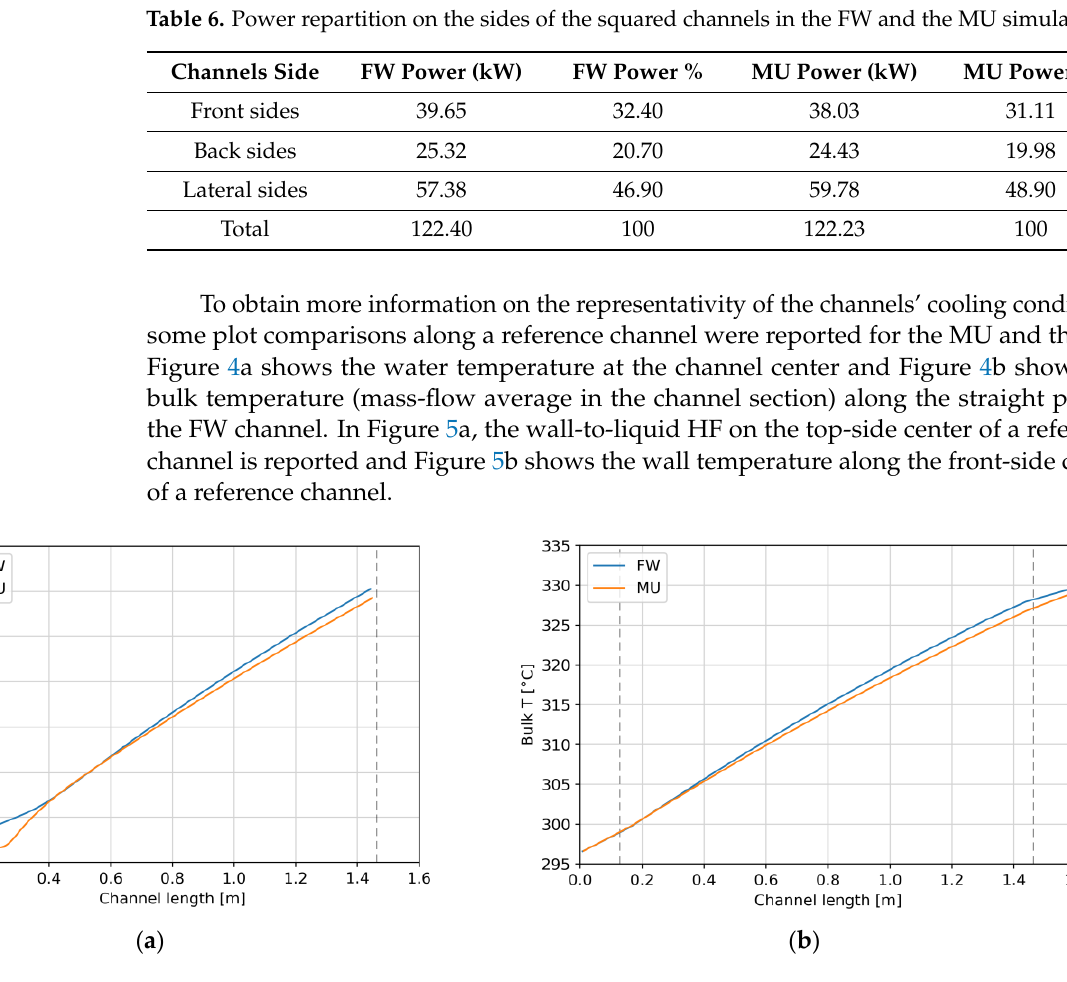
Figure 4. Channel-center temperature ( a ) and bulk temperature ( b ), along the length of a reference channel.